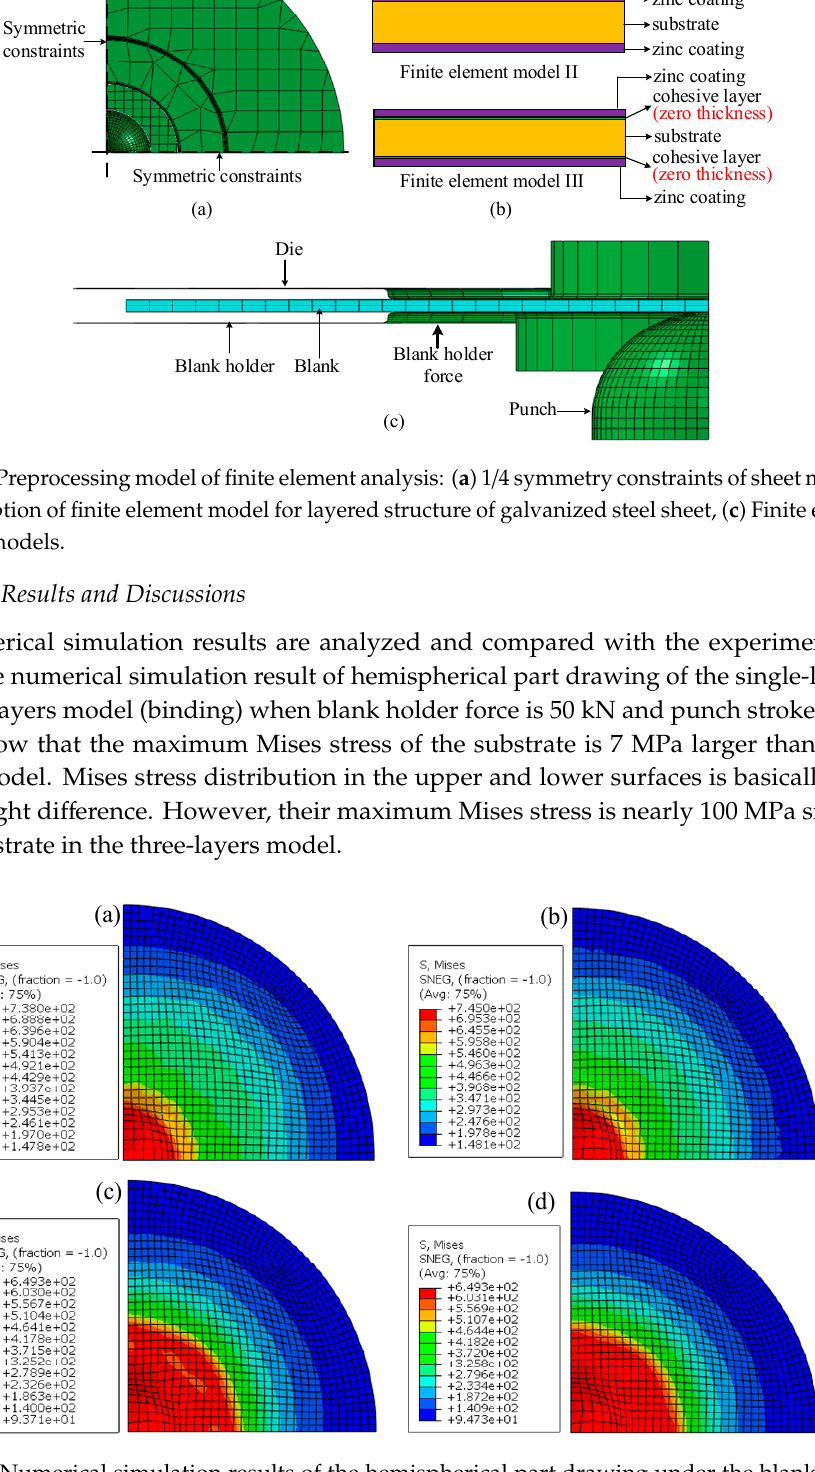
(b) Figure 12. Strain measurement after white light scanning (blank holder force is 115 kN): ( a ) White light scanning sample, ( b ) Measurement results of major strain. 4. Damage Simulations of Zinc Coating 4.2. Damage Model Based on Cohesion Element To explore and improve the zinc coating damage numerical simulation of galvanized steel sheet stamping, numerical simulation analysis was performed by using the blank holder force condition and the drawing depth as the stamping stroke. The zinc damage simulation of galvanized steel sheet is analyzed by establishing a finite element model considering the zinc coating. The model of finite element analysis is completely consistent with the experimental model. Abaqus ® 6.14 version software is used to carry out the finite element numerical simulation of hemispherical part drawing. To promote the efficiency of computation, the 1/4 model is adopted to analyze, and it adds symmetric constraints to the nodes on the X axis and the Y axis, as shown in Figure 13a. The final finite element analysis model is presented in Figure 13c. Three models are used to describe the material structure of galvanized steel sheet, as illustrated in Figure 13b. The element type of sheet metal is a solid element. The first model (Finite element model I, single-layer model) is to analyze the coating and substrate as a unified material, and the mechanical parameters are the data of uniaxial tension of galvanized steel sheet. The second (Finite element model II, three-layers model) and third (Finite element model III, five-layers model) models consider the substrate and the coating as two materials. Among them, the mechanical parameters of the substrate are the uniaxial tensile data for removing the zinc coating, but the mechanical parameters of the zinc coating are obtained by the Nano-indentation test and calculation. The adhesion between the coatings and the substrate of the second model are constrained by tie binding. Stiffness data transfer is equivalent to the rigid